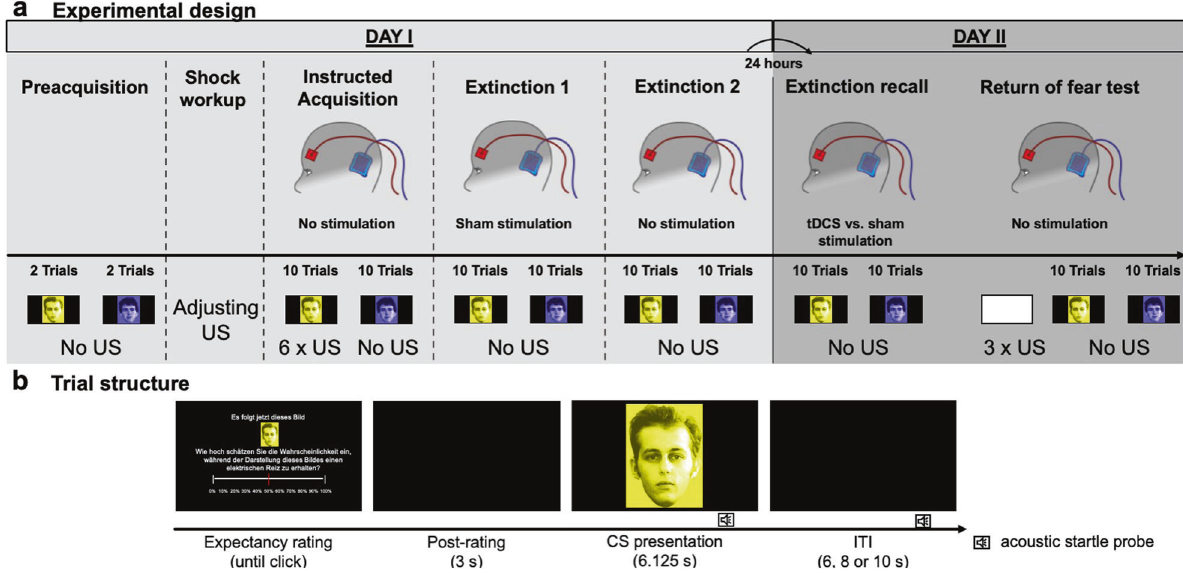
Fig. 1 Schematic structure of the experimental design and an experimental trial. a Experimental structure. The fi rst day started with a preacquisition phase, where CS + and CS − were presented twice without any US. Next, the US-intensity was adjusted to be perceived as unpleasant, but not painful by the participant (shock workup). During the following acquisition, fi rst (extinction 1) and second half of extinction training (extinction 2), CS + and CS − were presented 10 times, each. During acquisition, 6 CS + trials were paired with the US, while no US was presented during the CS − or during extinction. The second experimental session followed 24 h later and began with an extinction recall phase, where CS + and CS − were each presented 10 times without any US. A following return of fear test started with a reinstatement procedure, during which the background color of the monitor changed to white and three non-signaled USs were administered. Then, CS + and CS − were each presented 10 times without the US. TDCS electrodes were always attached aside from preacquisition and shock workup, but electrical currents were only applied during extinction 1 (sham stimulation) and extinction recall (tDCS vs. sham) to minimize contextual effects. b Trial structure. A prompting slide required participants to rate the expectancy (in percent range 0 – 100) to receive a shock during an upcoming CS presentation (English translation: “ Next, this picture will follow. How likely do you think is it, to receive an electrical shock during the upcoming presentation of this picture? ” ). After a three-second post-rating interval, the CS was presented full-size, followed by an inter-trial interval (ITI). Startle probes were administered during CSs and